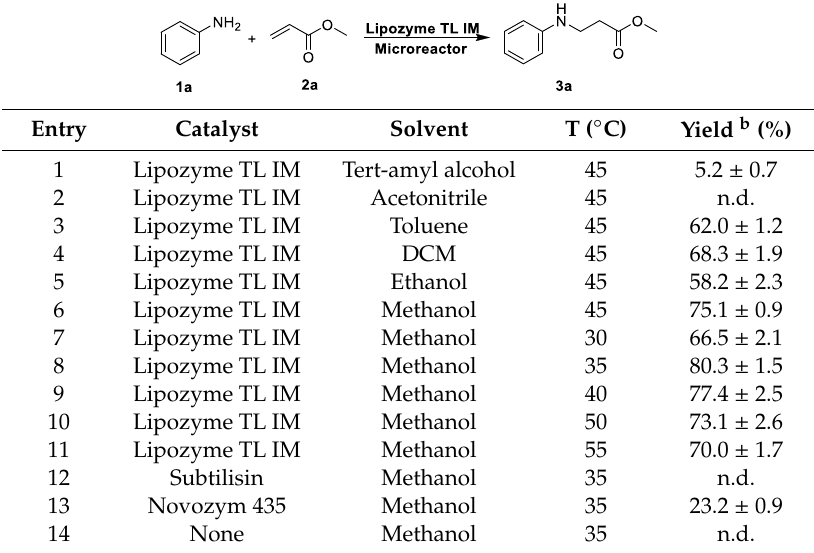
Table 2. Solvent, temperature and enzyme screening for enzymatic synthesis of β-amino acid esters. a